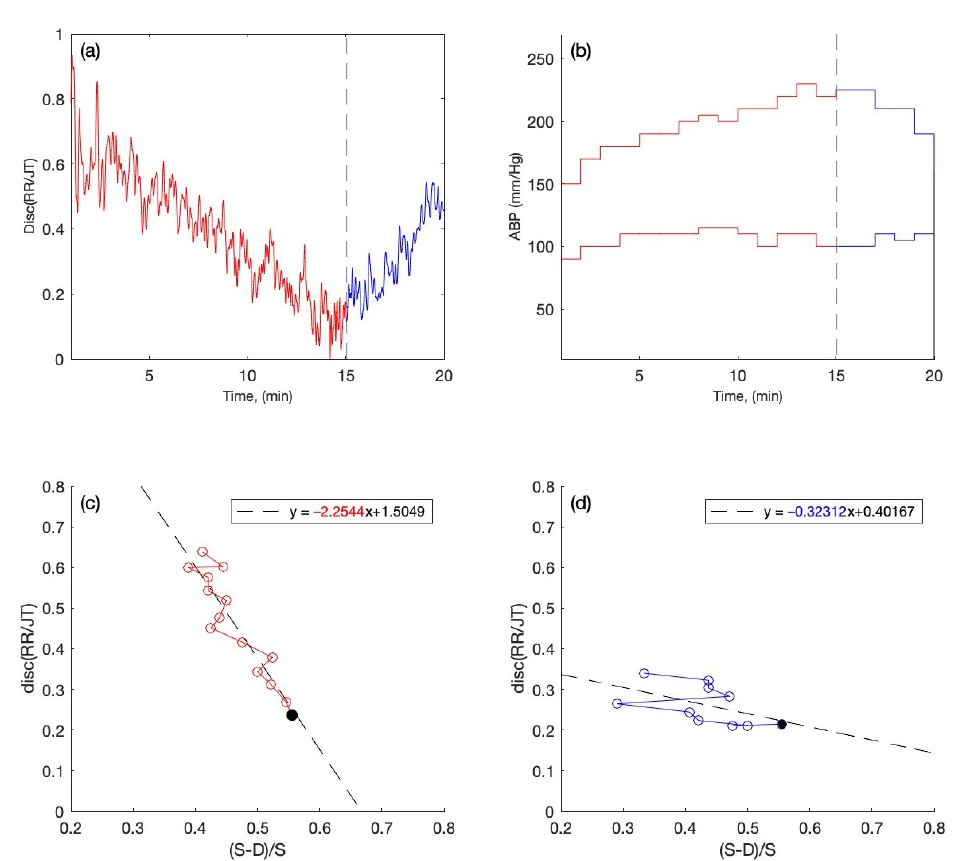
Figure 4. The readings are presented for the person with high ABP. ( a ) Disc (RR/JT) changes up to 15 min during the load and after 15 min during recovery. ( b ) Variations in Systolic and Diastolic ABP during the stress test. ( c ) The phase plane for the parameters X = (S − D)/S and Y = Disc (RR/JT) and the linear regression plot, where the data for each parameter are presented as a one-minute mean during the load and ( d ) during the